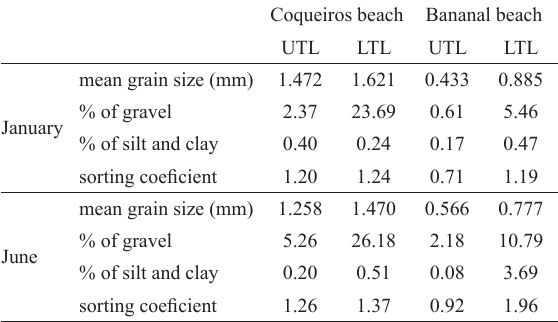
Granulometric parameters of Coqueiros and Bananal